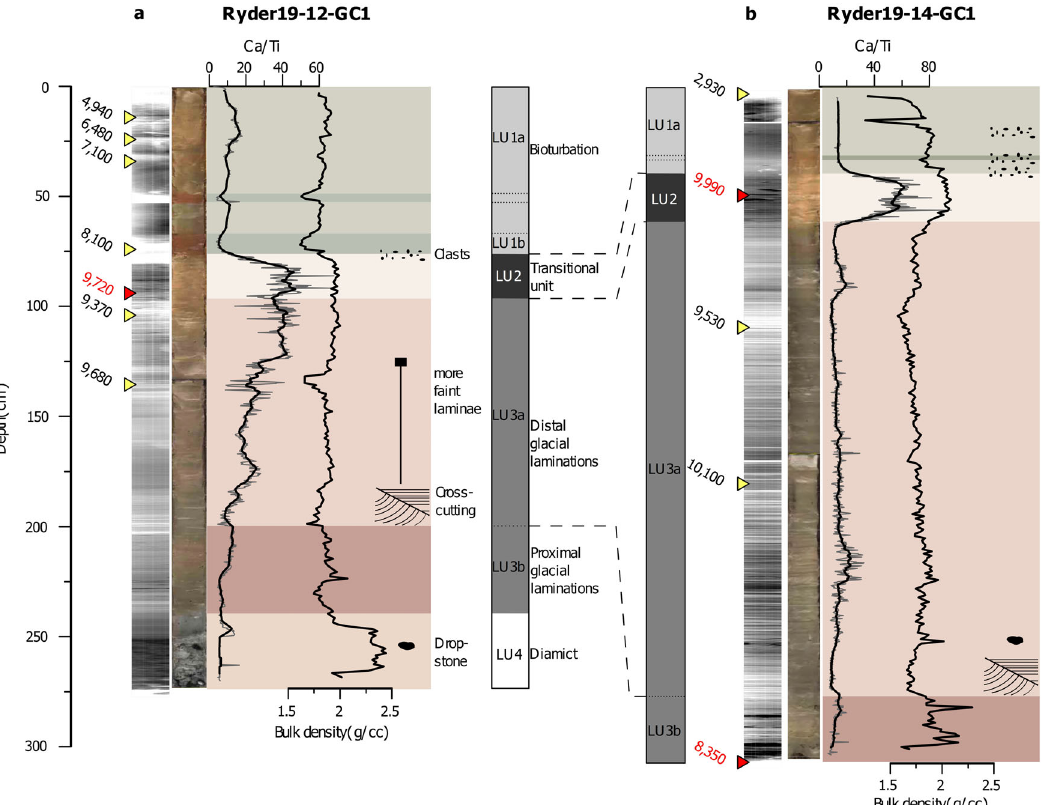
Fig. 5 Lithology of 12-GC and 14-GC. Radiograph, core photo, XRF Ca/Ti (grey, 20-pt average in black) and bulk density (black) of ( a ) 12-GC and ( b ) 14-GC, including prominent sedimentary features (dropstones, cross-cutting, IRD/clasts). Key lithological boundaries can be correlated between 12-GC and 14-GC, for the respective depth of LU boundaries see Supplementary table 1. Uncalibrated radiocarbon ages and their respective depth are marked with yellow triangles. Red triangles mark outliers, which are excluded from the fi nal age